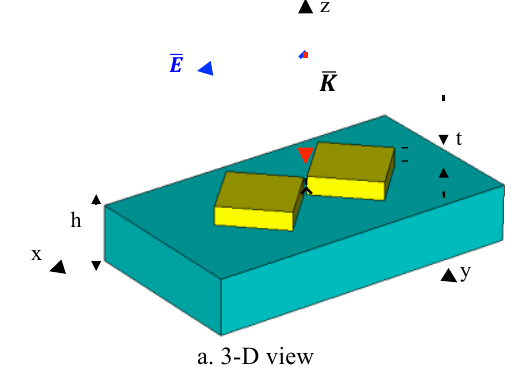
Figure 1: The variations of complex permittivity and electrical conductivity versus frequency for different types of